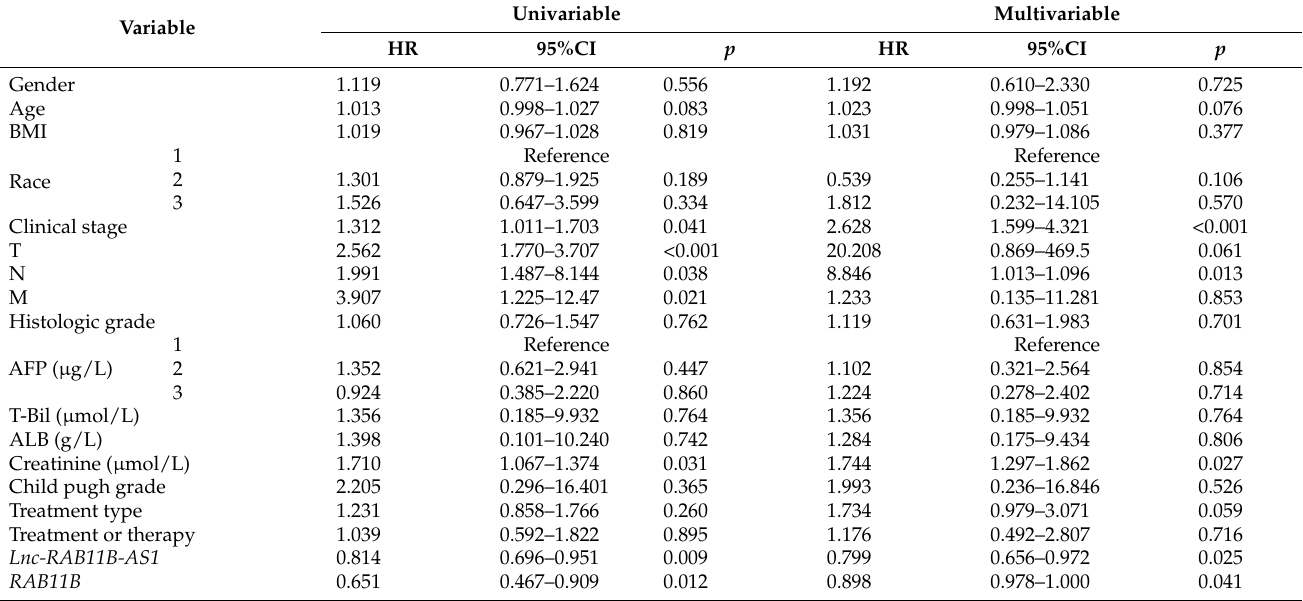
Table 3. Univariate and multivariate Cox regression analyses of clinicopathologic characteristics associated with OS in TCGA